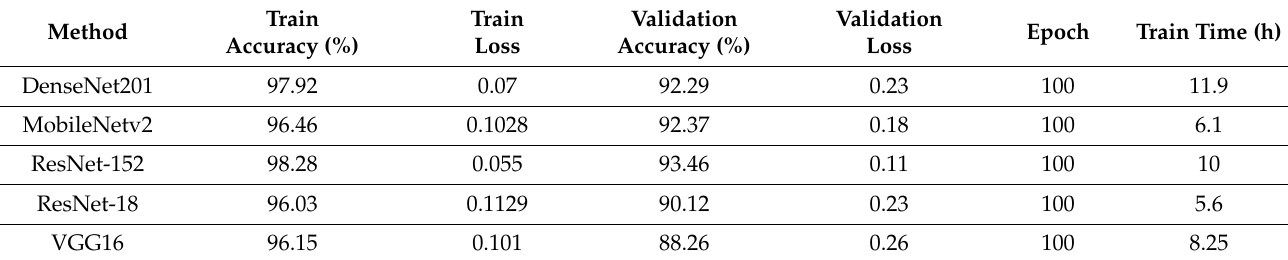
Table 2. Detailed information on the training results of the CNN models.